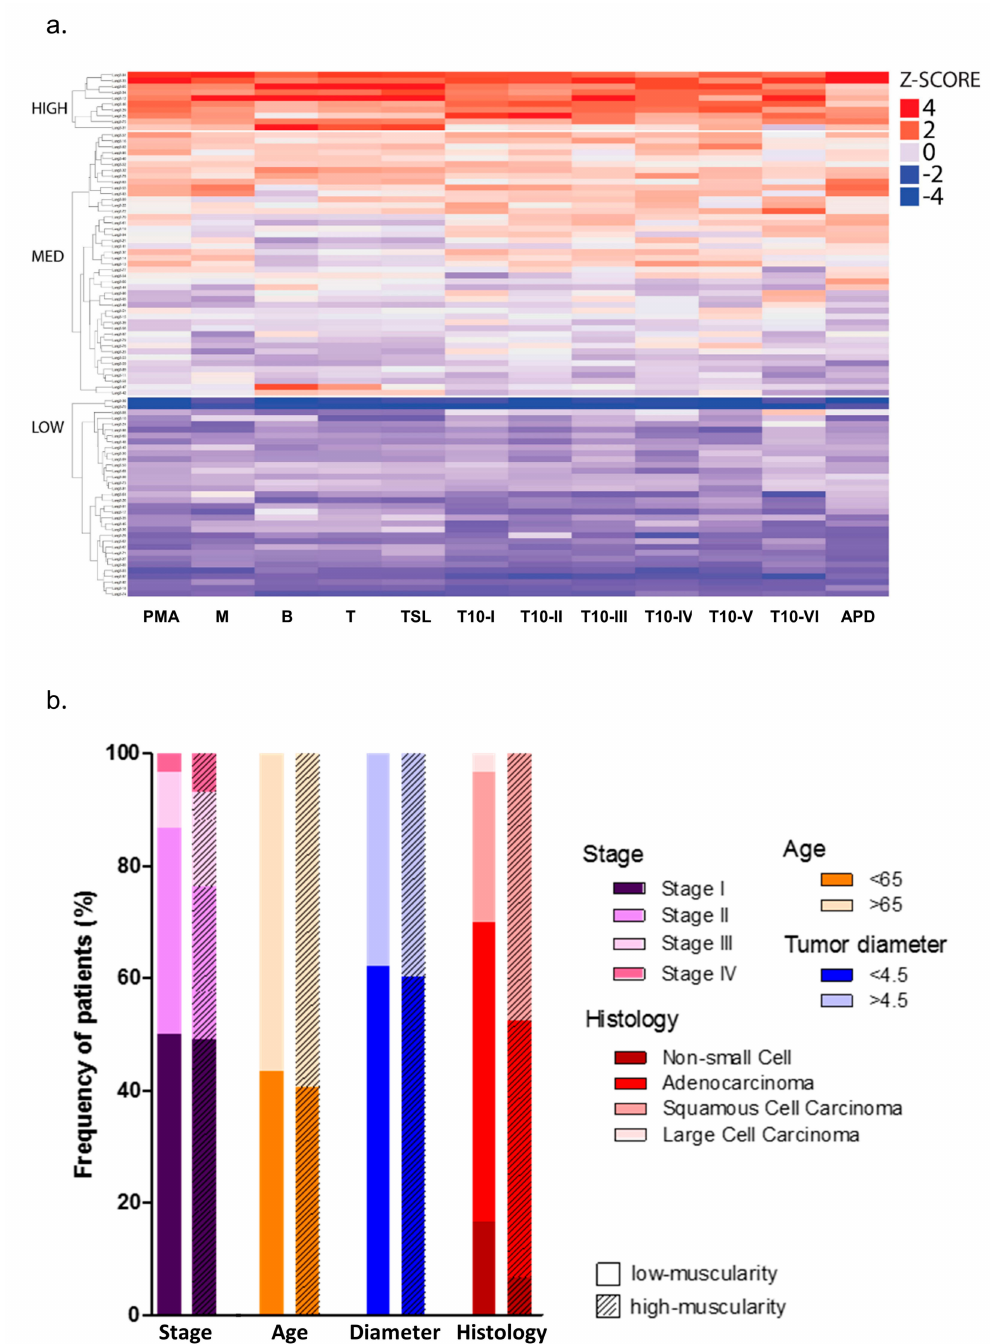
Figure 2. Pectoralis muscle area as an approach for screening muscularity. ( a ) Heatmap showing patients’ stratification into high-, medium-, and low-muscularity by non-hierarchical k-means clustering analysis of the pectoralis muscle area (PMA) and its normalization by eleven computed tomographies (CT) feature that includes: manubrium and sternum body lengths, six T10 (tenth thoracic) di ff erent measures, and an anteroposterior length. Manubrium length (M); sternum Body length (B); T (M + B); total sternum length (TSL); T10 body vertical length (T10-I); distance between T10 body and spinous process (T10-II); T10 body horizontal length (T10-III); distance between T10 pedicles (T10-IV); distance between T10 transverse processes (T10-V); T10 body area (T10-VI); anteroposterior distance (APD). ( b ) Bar graphs comparing the percentage of patients for clinical prognostic variables between high- and low-muscularity groups. These groups were generated